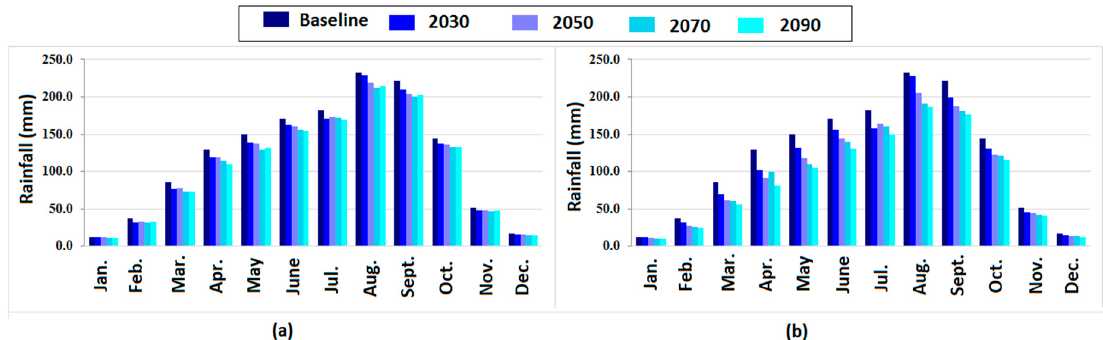
Figure 5. Monthly inter-annual mean rainfall for Horizons 2030, 2050, 2070, and 2090 in the Sassandra River Basin: ( a ) RCP 4.5; ( b ) RCP 8.5.